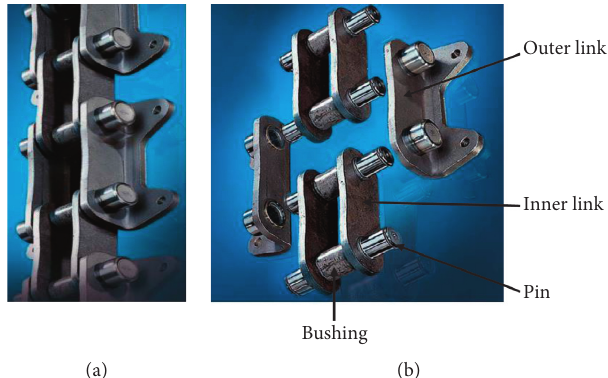
Figure 1: Typical chain link